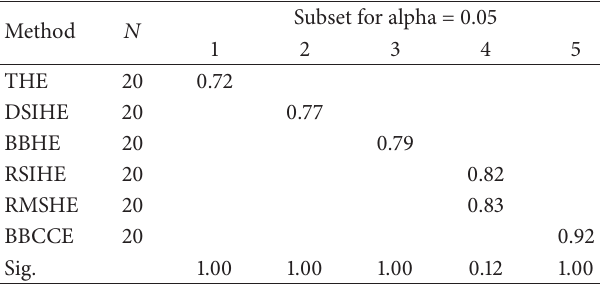
Table 8: Categorization of contrast enhancement methods into homogenous subset using Duncan’s test for FSIM.